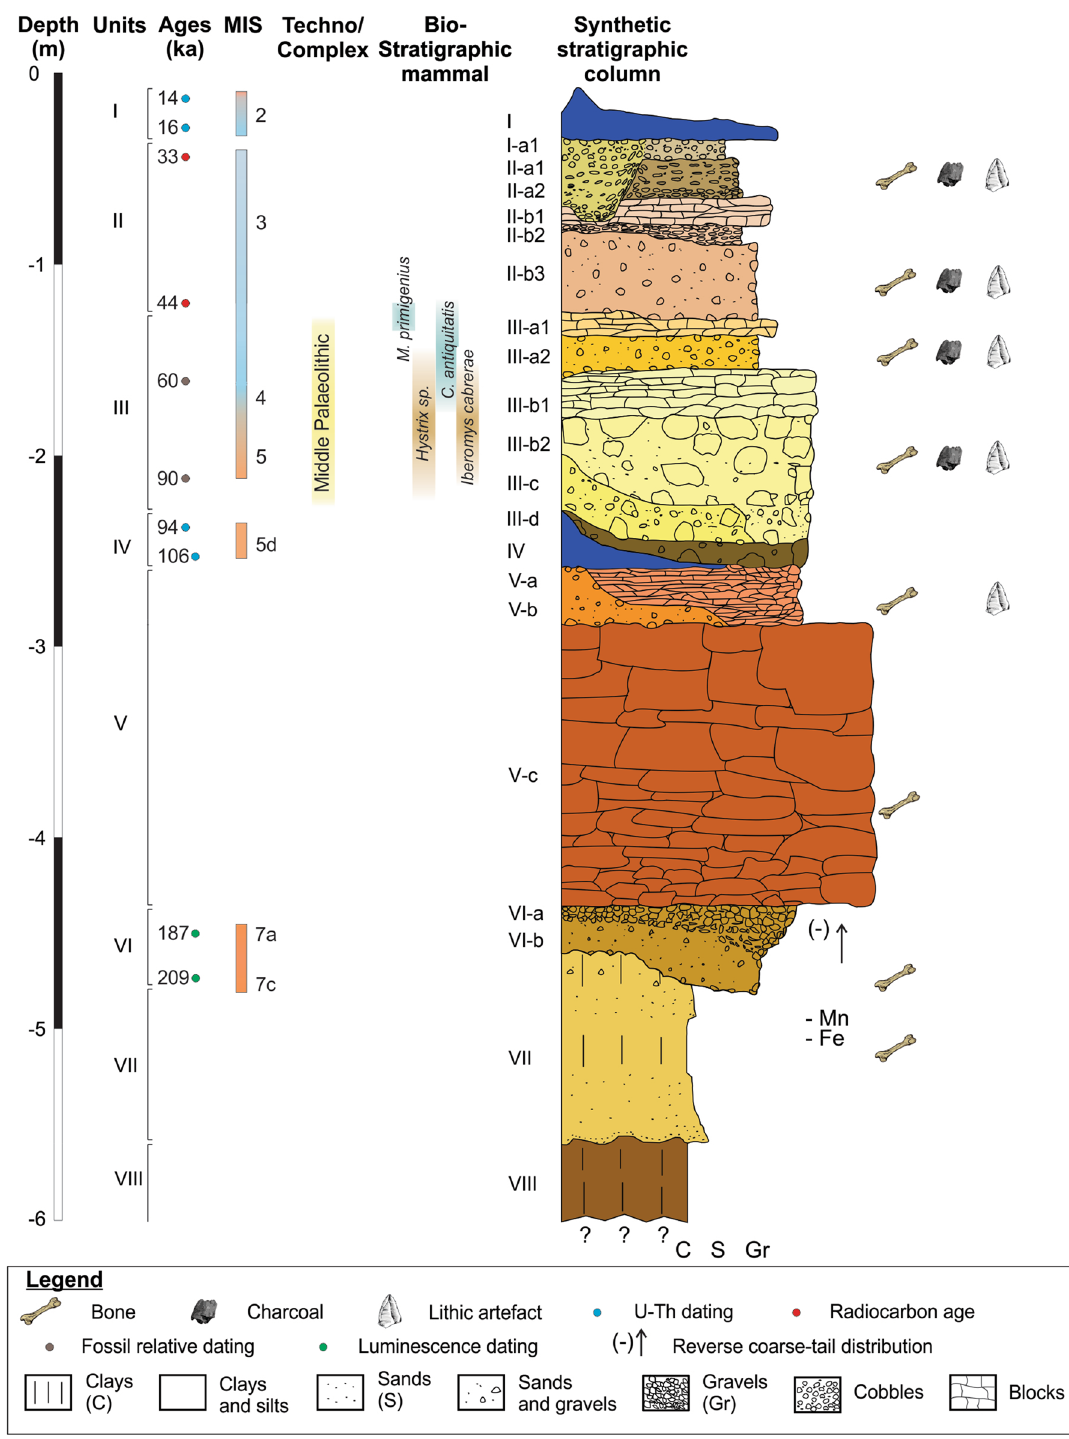
Figure 3. Synthetic stratigraphic column of Chamber X in Teixoneres Cave. References 29,32,49–52